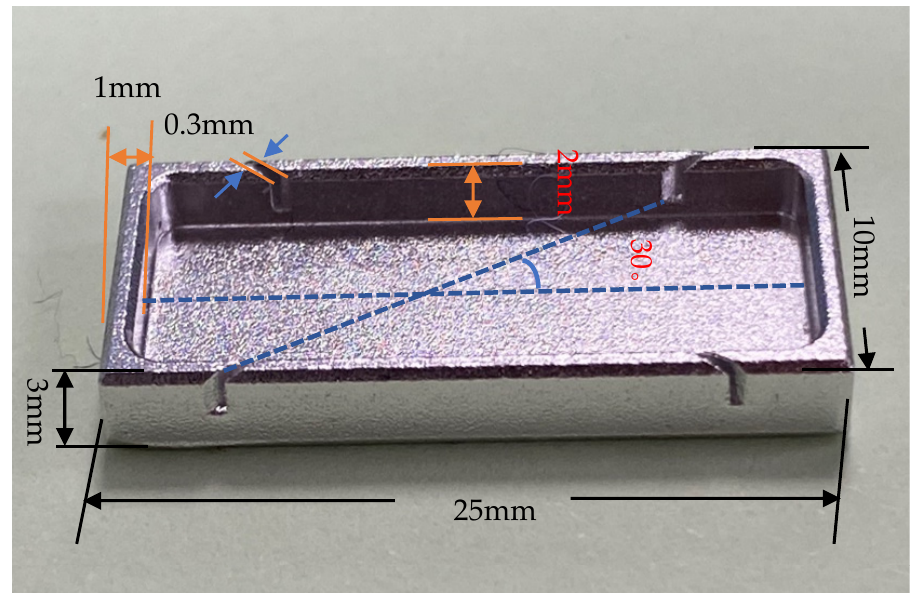
Figure 10. Mold of Sensor Fabrication.